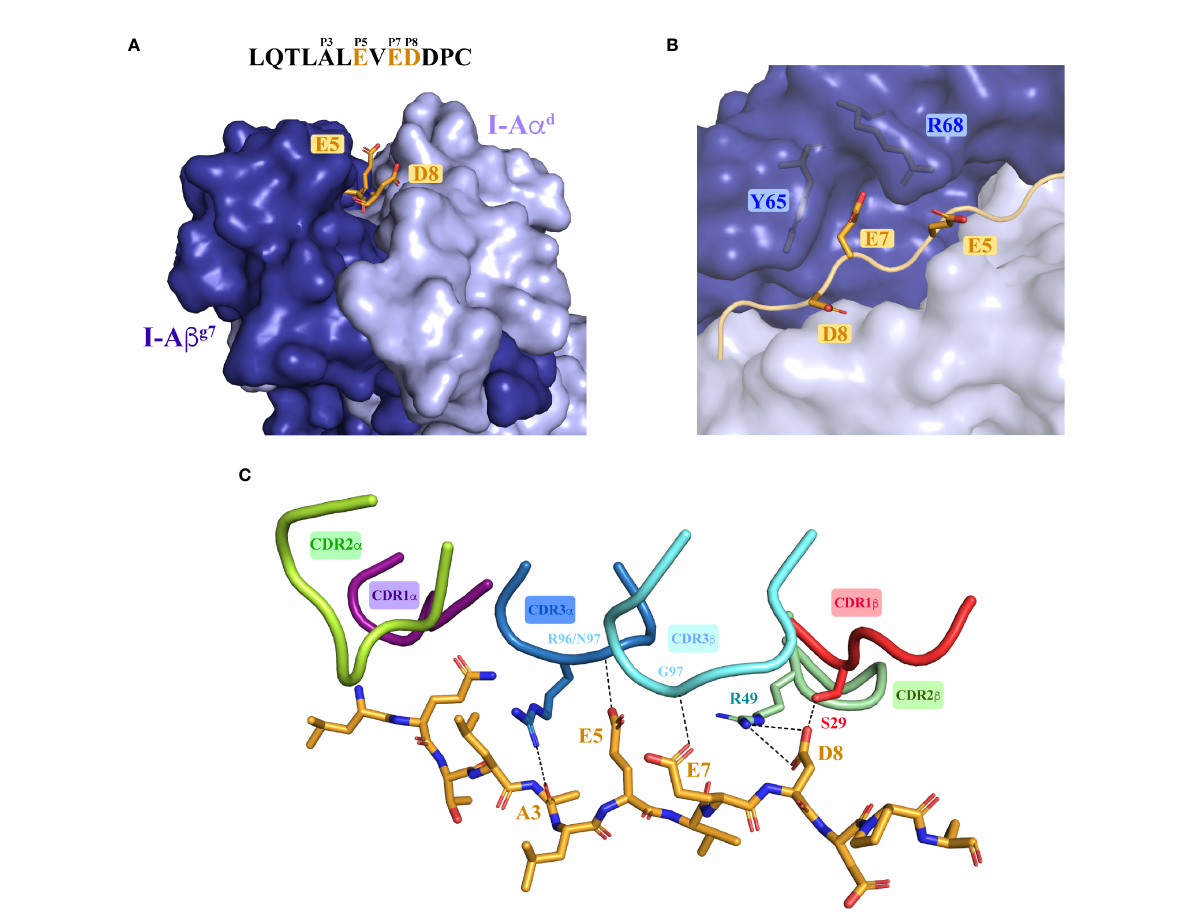
FIGURE 5 Molecular recognition of the agonistic I-A g7 -presented HIP39 antigen by the diabetogenic 4.1-TCR. (A) Front view of the I-A g7 molecule, shown as surfaces with the I-A a d and I-A b g7 chains colored light and deep blue. The HIP39 (displayed as an orange ribbon in the MHC groove) residues Glu5, Glu7 and Asp8 are highlighted as sticks. The sequence of HIP39 is shown above the molecule with the acidic interacting residues highlighted in orange. (B) Detail of Glu7 in the HIP39 embedded in the P7 pocket between Tyr65 and Arg68 in I-A b g7 . (C) Polar and ionic interactions (dashed lines) established between the 4.1-CDRs and the HIP39 peptide. The CDR colors are consistent with those shown in Figure 2. Note that VDW contacts with CDR1 a are not displayed. The CDR2 a does not contact the